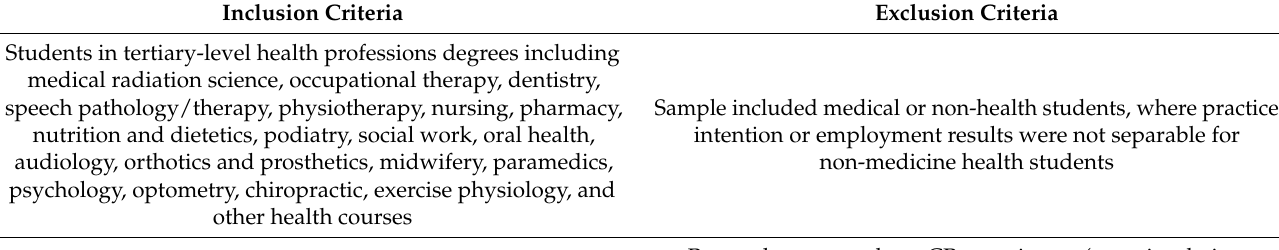
Table 1. Article inclusion and exclusion